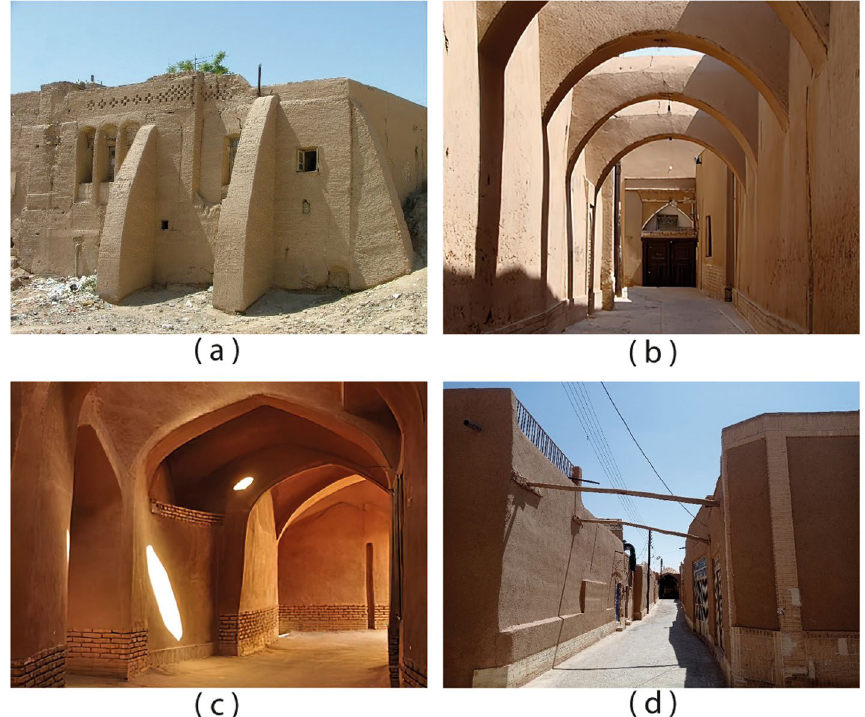
Fig. 22 Different techniques for counteracting lateral loads in Yazd: ( a ) masonry buttresses (Source: Asgharian Jedi and Owlia 2013), ( b ) masonry arches, ( c ) Sabat, and ( d ) timber elements. (Source of b‑d: the